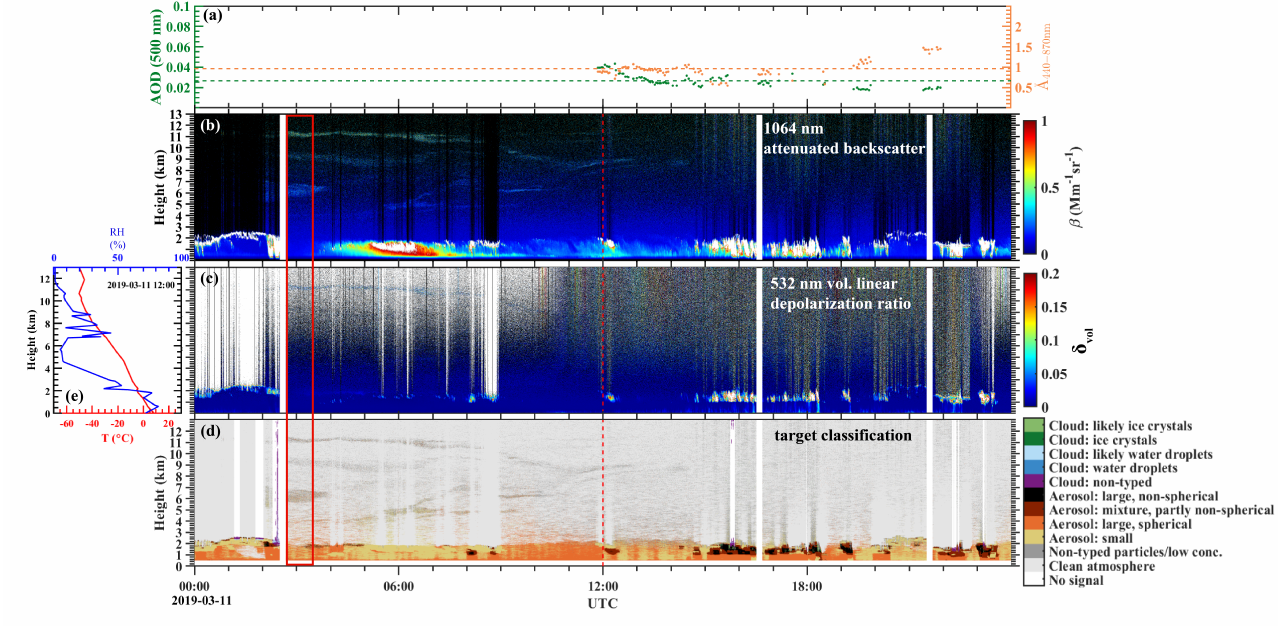
Figure 6. Sameas Figure 2 but for 11 March 2019. The averaging period for the profiles shown in Figure 9 is indicated by the red rectangul.